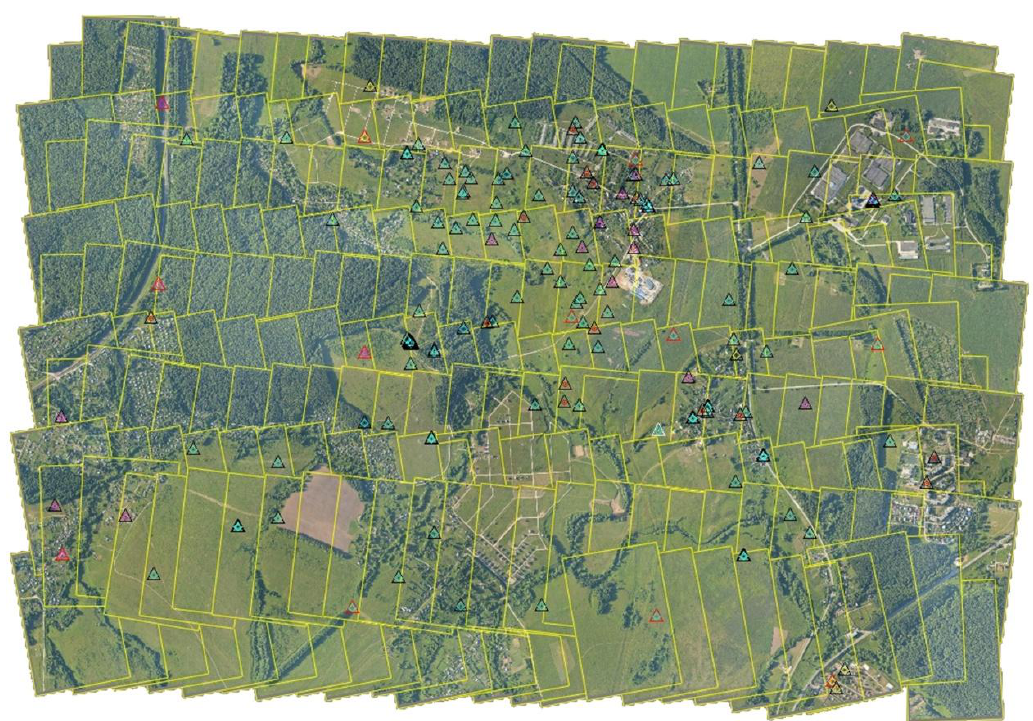
Figure 2. Zaoksky Geopoligon of MIIGAiK For carrying out field calibrations were used test area “Zaoksky Geopoligon” of MIIGAiK and digital photogrammetric system PHOTOMOD and